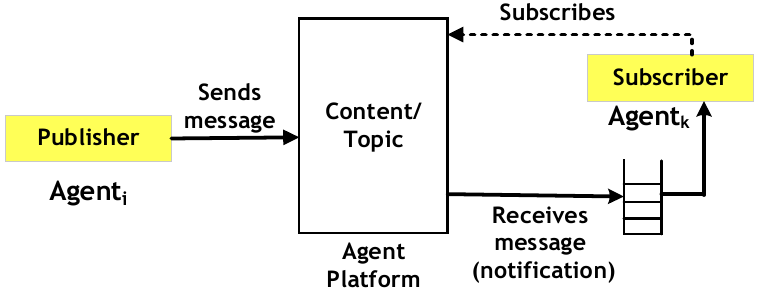
Figure 1. An asynchronous message exchange model designed using content-based publish-subscribe.